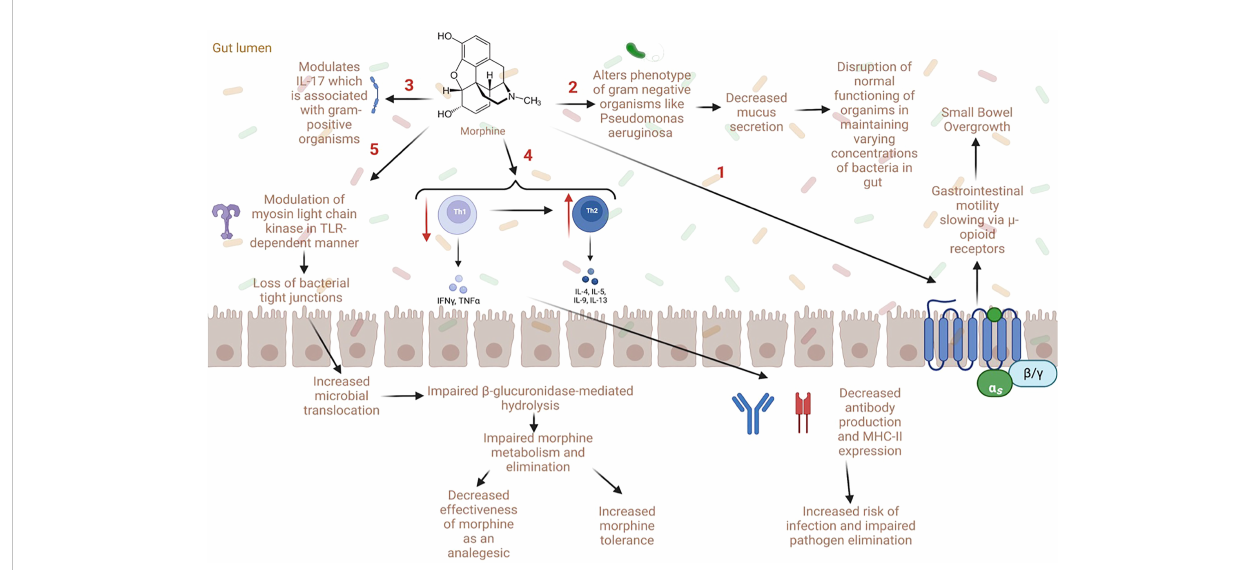
FIGURE 2 Proposed mechanisms of gut dysbiosis and microbial translocation with opioid use (1) Opioid use is associated with decreased gastrointestinal motility via direct action on m -opioid receptors. This can lead to small bowel overgrowth, gut dysbiosis, and microbial translocation. (2) Some opioids (e.g., morphine) have been shown to directly alter the phenotype of gram-negative organisms such as Pseudomonas aeruginosa which causes decreased mucus secretion in the gut, altering microbial homeostasis. (3) Opioids can also worsen sepsis via modulation of IL-17 by gram-positive organisms. (4) Opioids also cause a decrease in Th1 and an increase in Th2 cells which lead to decreased antibody production and MHC-II expression; this increases the risk of infection and decreases pathogen elimination. (5) Lastly, opioids modulate myosin light chain kinase in a toll-like receptor dependent manner which causes loss of bacterial tight junctions and impaired gut barrier function. This increases microbial translocation and impairs b -glucuronidase-mediated hydrolysis, which can in turn impair morphine metabolism and elimination. Notably, alterations in opioid metabolism can decrease the effectiveness of morphine as an analgesic agent and increase morphine